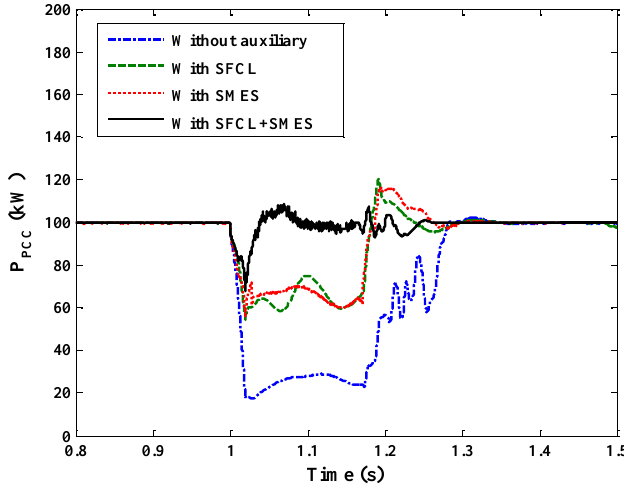
Figure 10. Characteristics of the PCC power under the symmetrical fault.